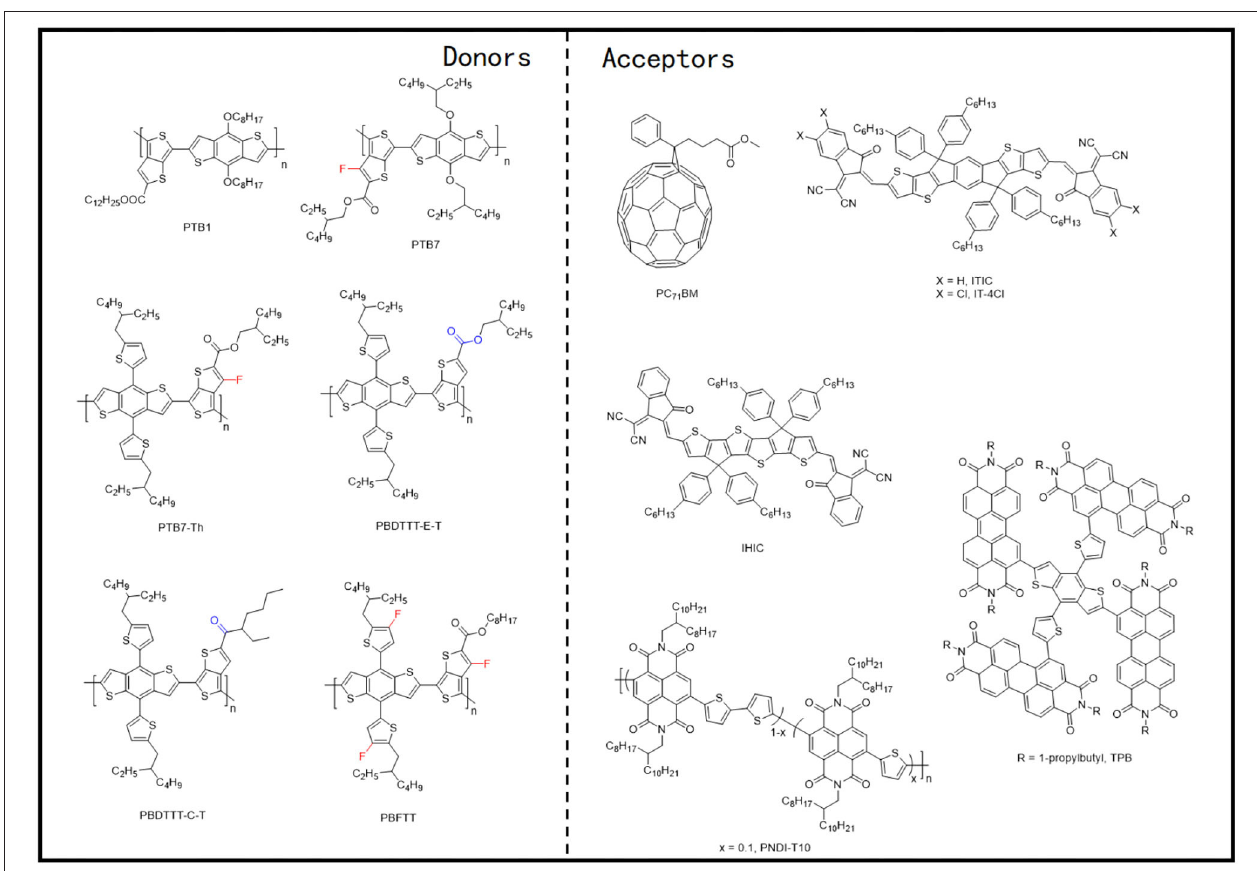
FIGURE 5 | Molecular structures of representative D-A copolymers and mentioned